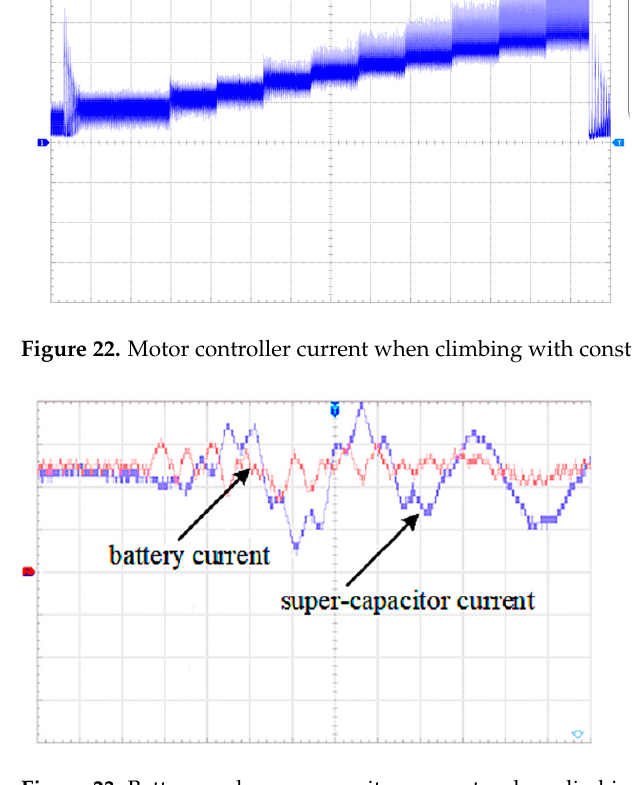
Figure 23. Battery and super-capacitor currents when climbing with constant speed.